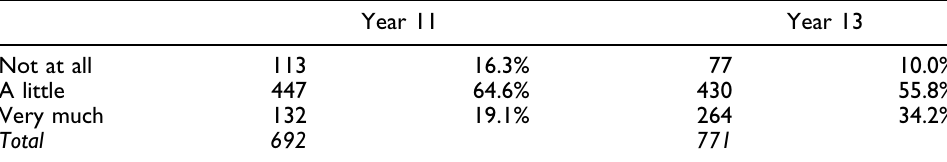
Table 6. Response frequencies to ‘ My school or college helps me to be the kind of person I want to be